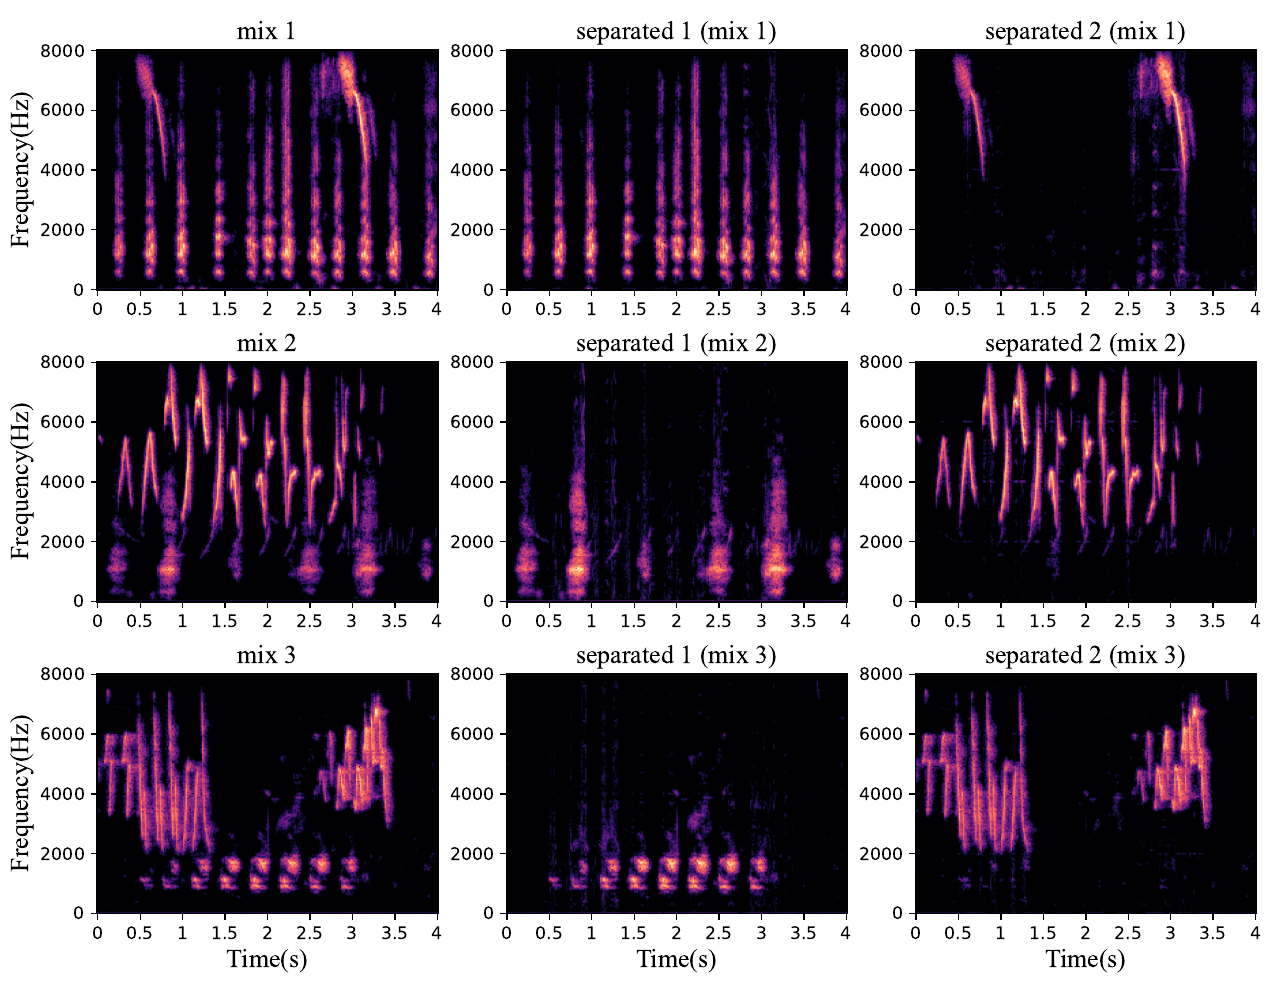
Figure 9. Some separation results of the dataset.